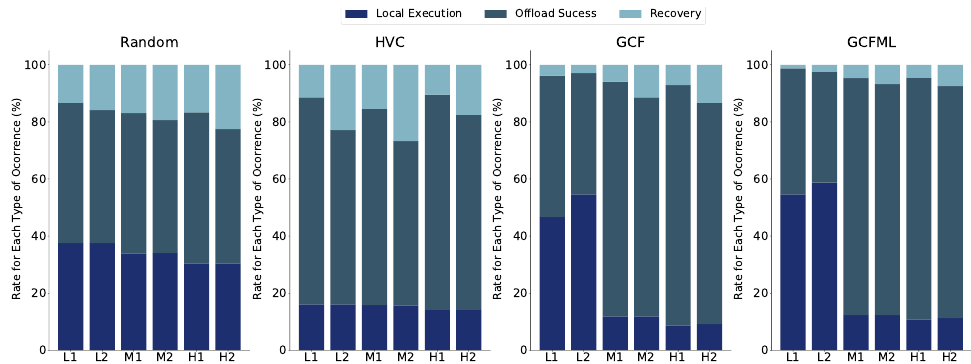
Figure 7. Offloading results for the highway